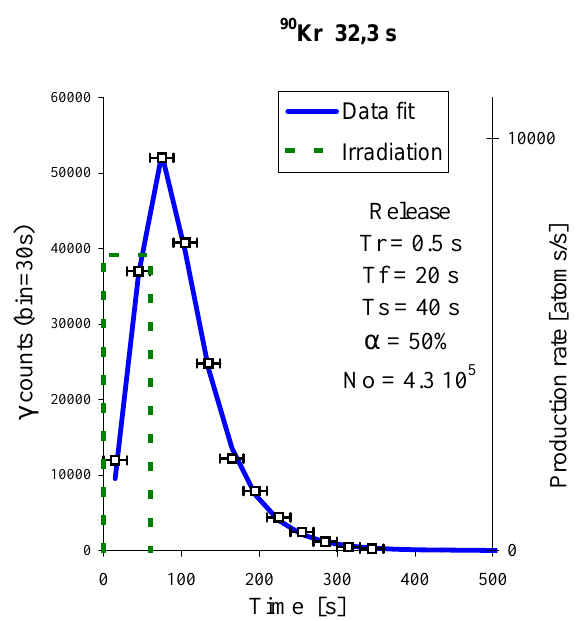
FIG. 2. (Color) Time distribution for release and transport of 92 Kr observed at cold finger. The solid line corresponds to a fit (see